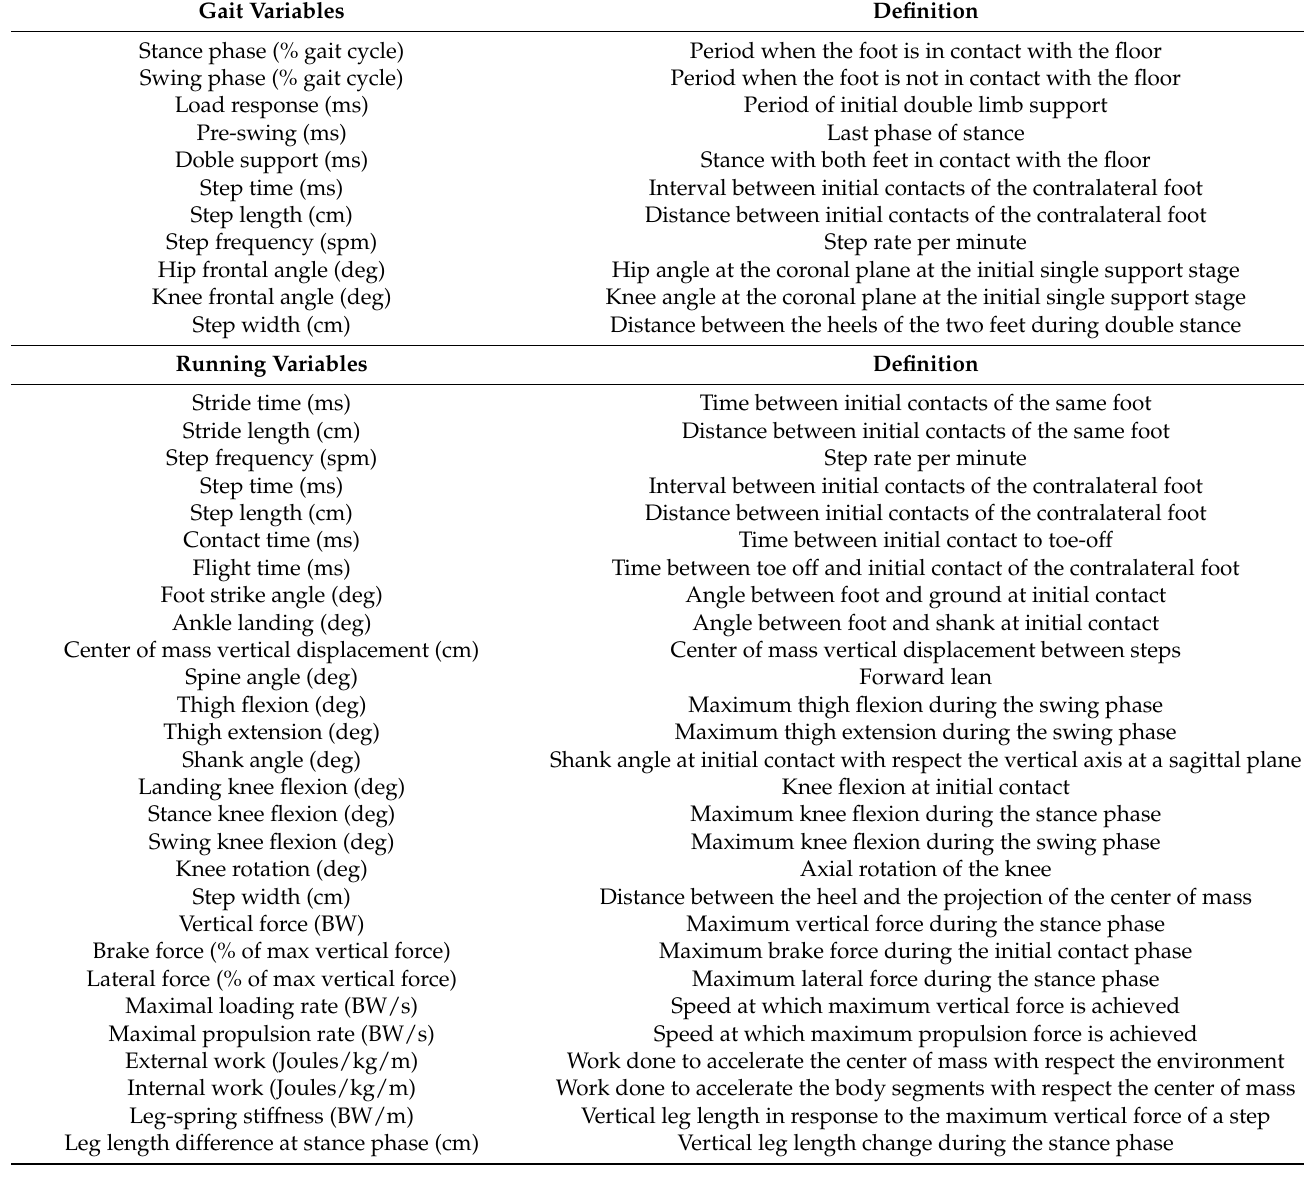
Table 1. Definitions of the variables provided by the MotionMetrix